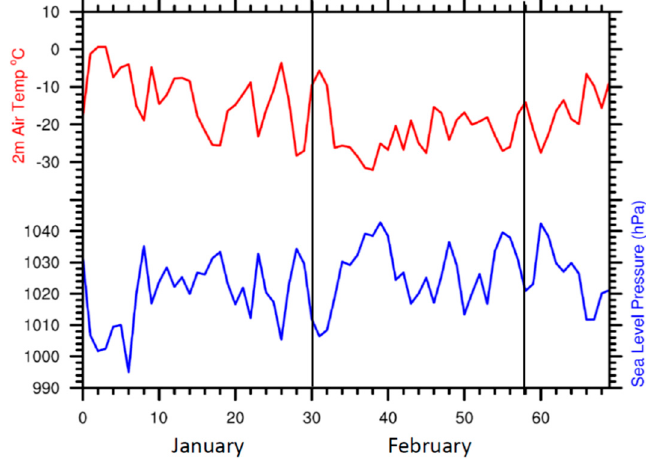
Figure 13. Time series of daily mean temperature (°C) and sea level pressure (hPa) over the Prairie region.